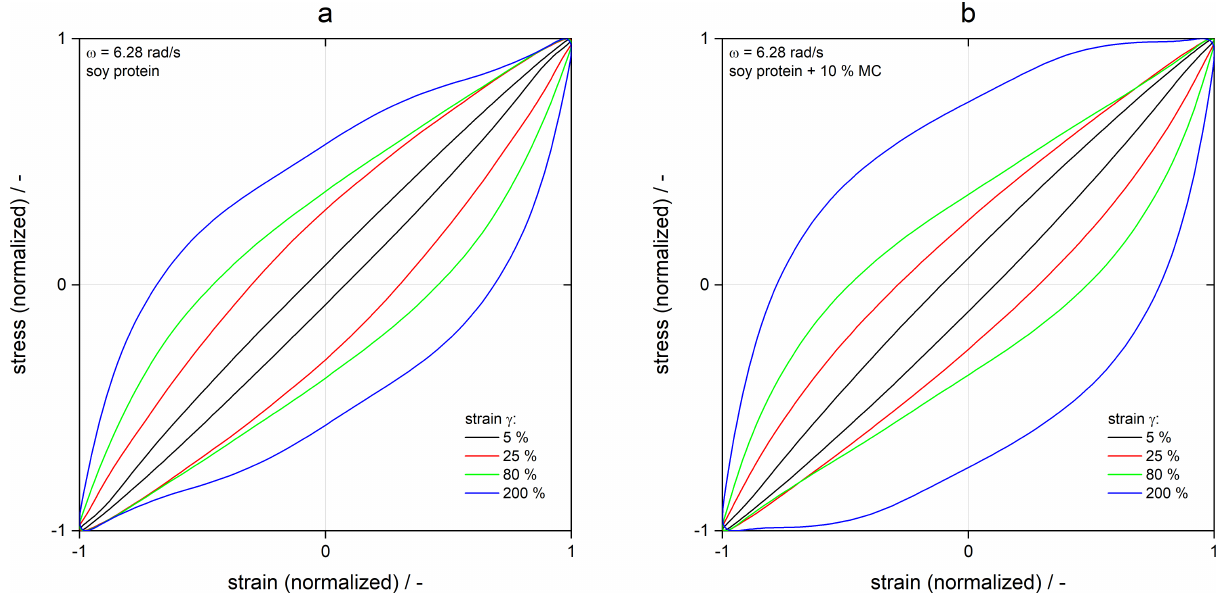
Figure 7: Lissajous-Bowditch Plots of the elastic part of material response from soy protein (a) and soy protein with 10% MC (b) at deforma- tions of 𝛾 = 5, 25, 80 and 200%. Exemplary raw data is given in the appendix.